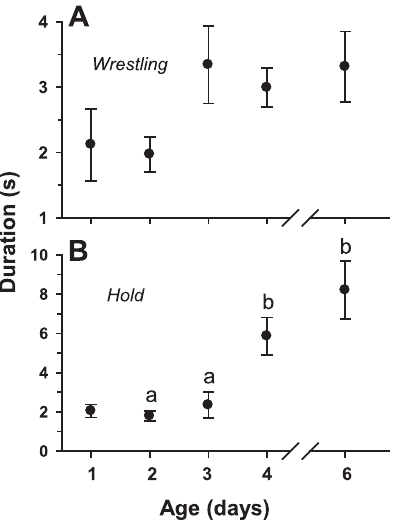
Figure 4. Bout durations of two high-intensity aggressive behaviors by age. (A) Wrestling . (B) Hold . Vertical bars indicate means 6 s.e.m. Different letters above the bars indicate significant differences.